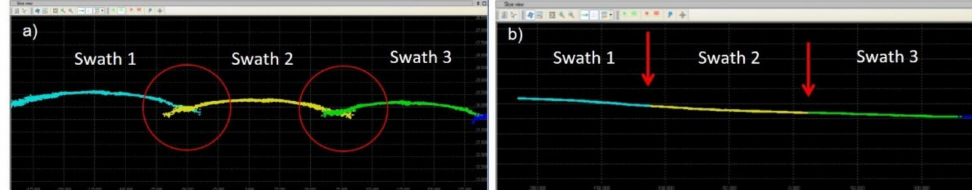
Figure 18. Comparison of multibeam echosounder depth measurement results with ( a ) the faulty sound velocity sensor and ( b ) with the sensor installed in a new under-keel